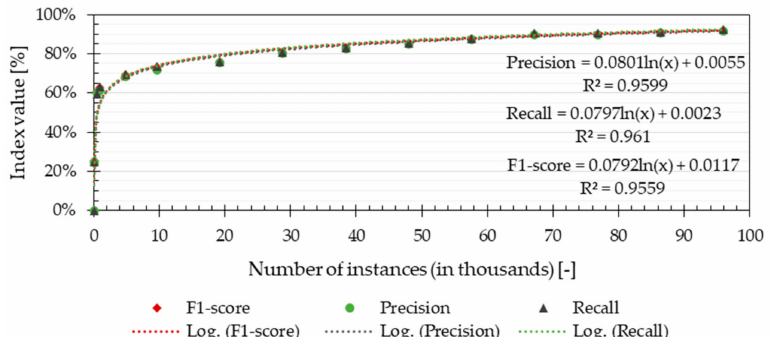
Figure 3. Overall performance of the prediction algorithm using the Validation approach as a function of the number of data points used as training set.